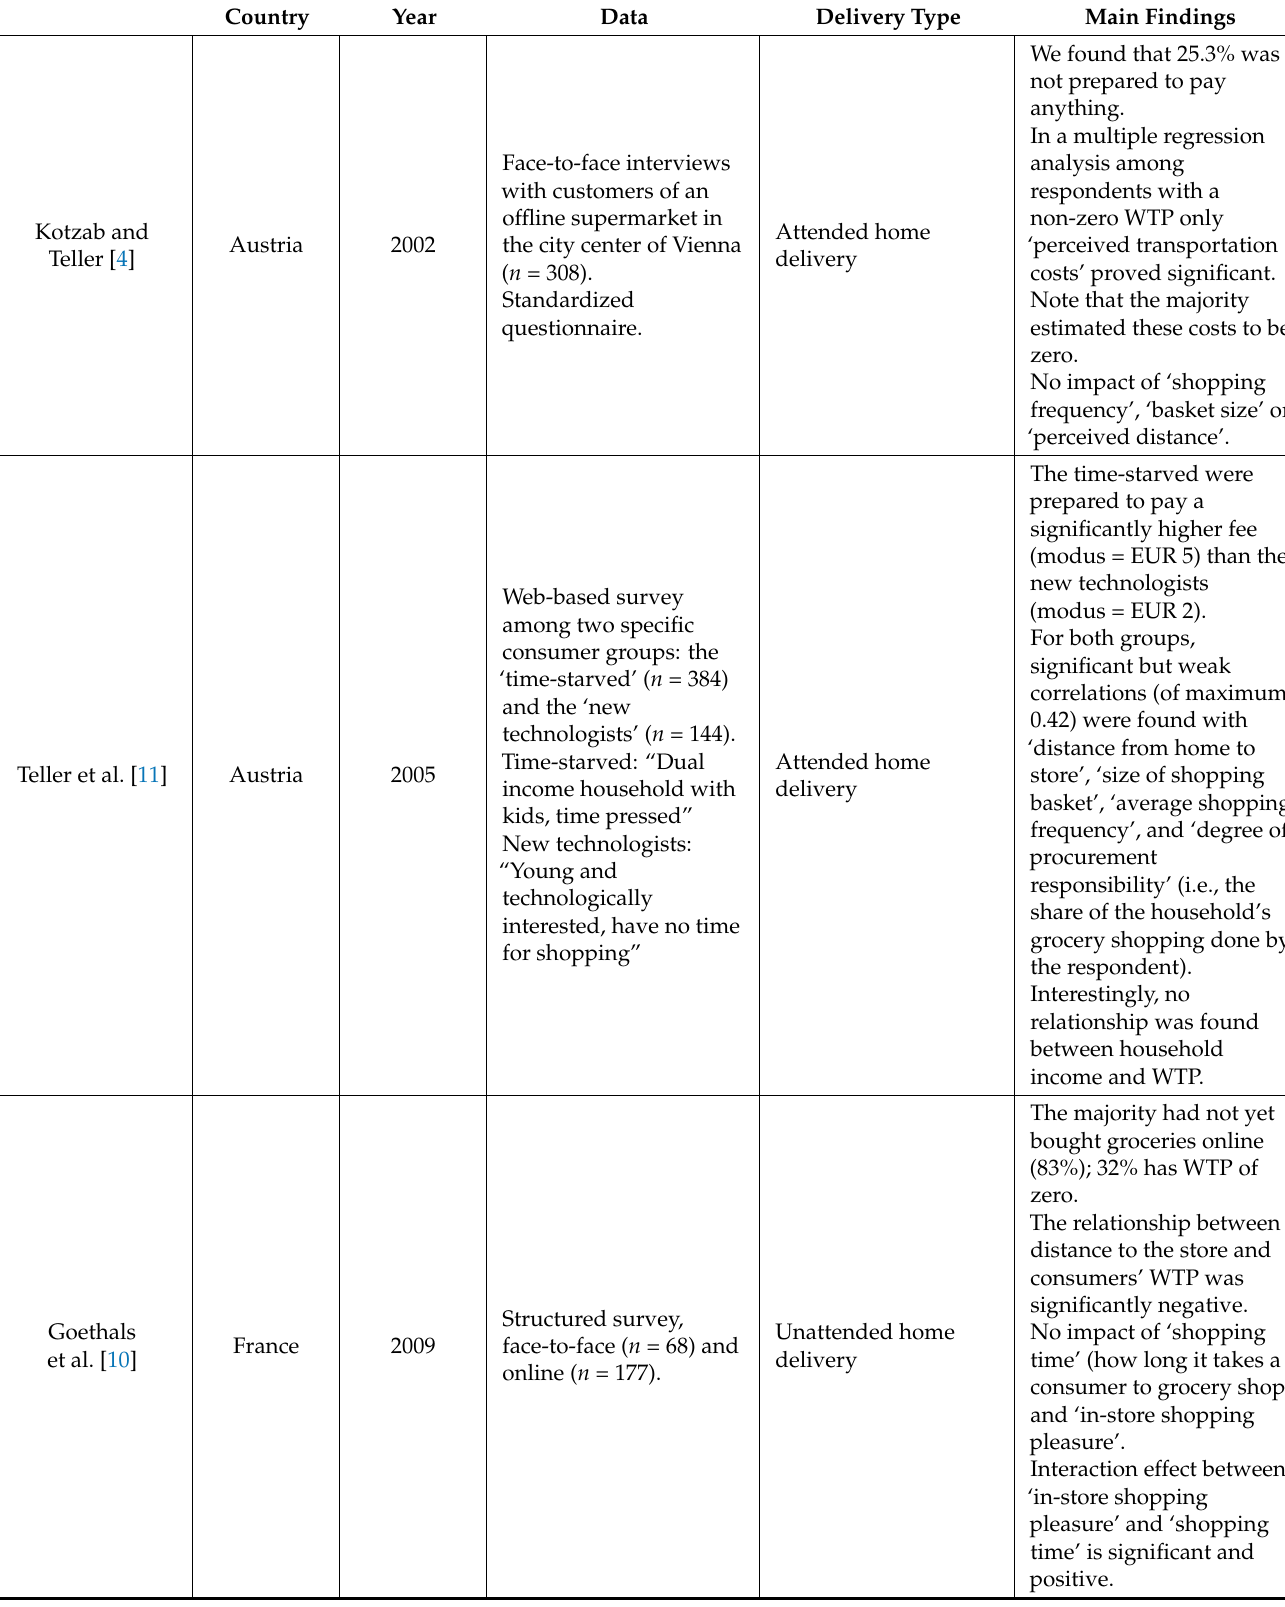
Table 2. Overview of studies on WTP for e-grocery